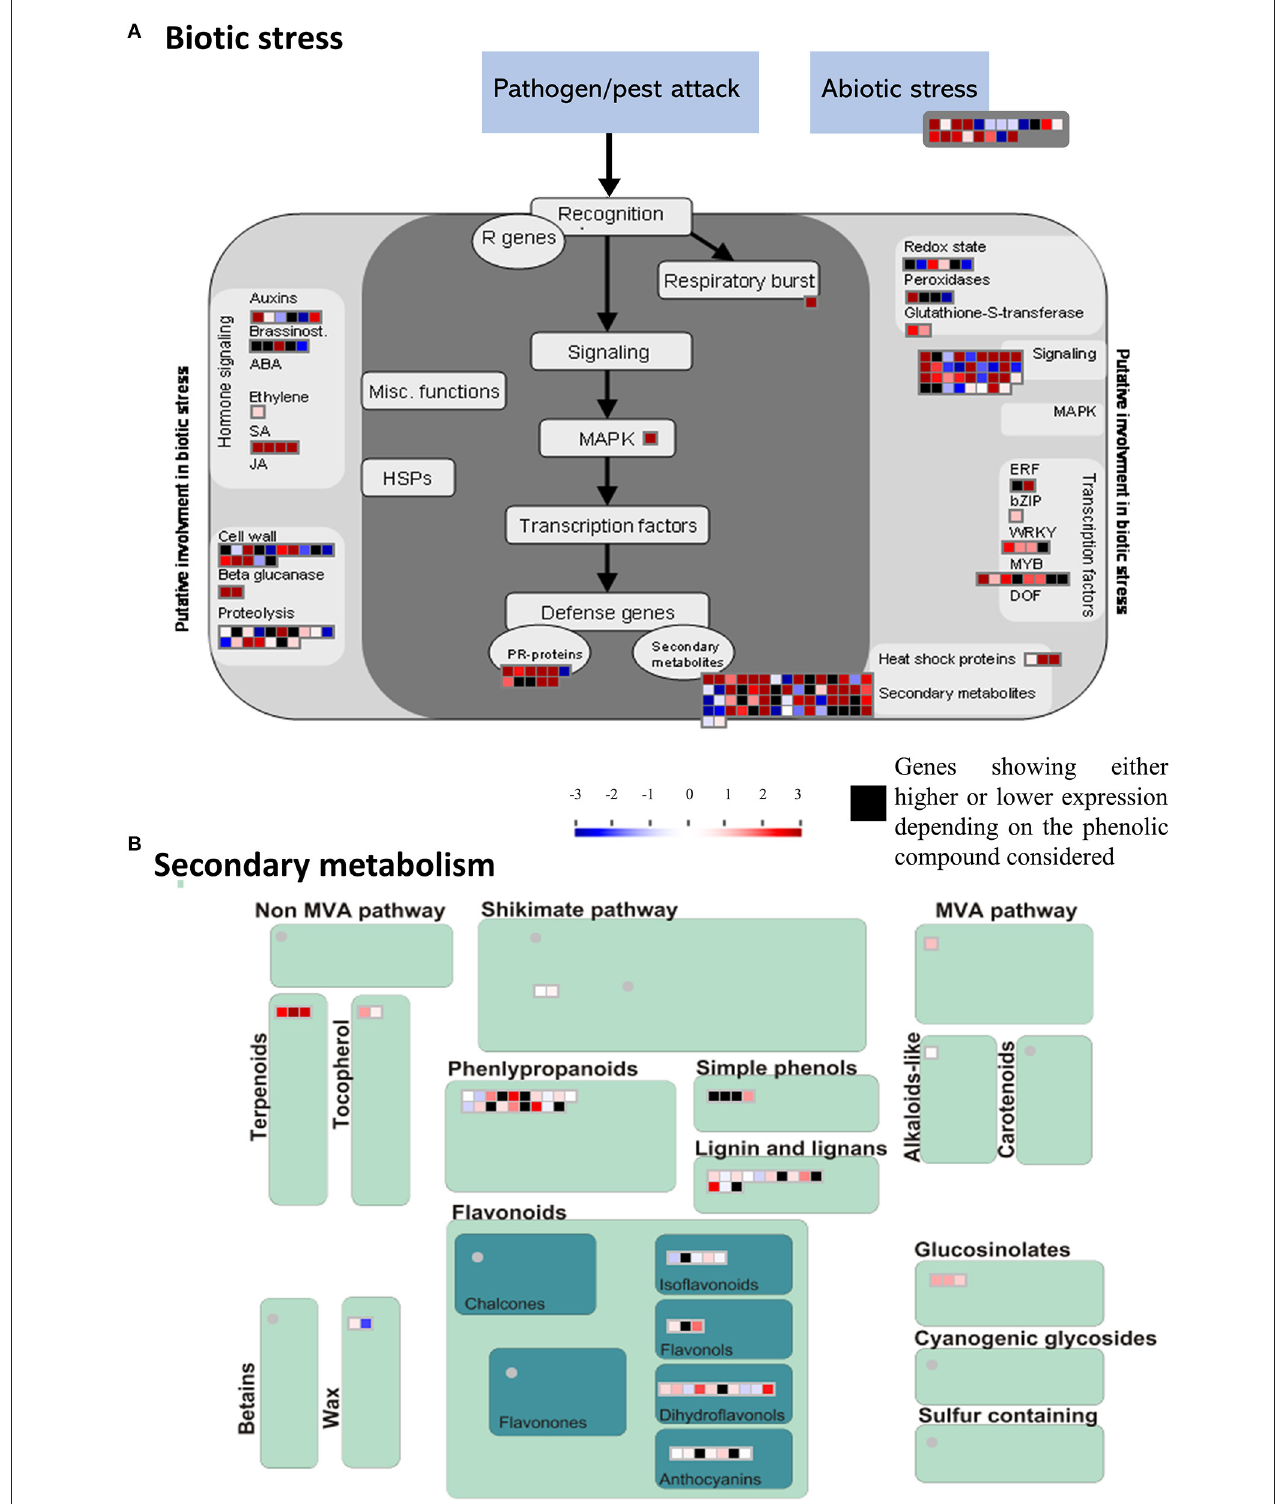
FIGURE 5 | MapMan-based classification of differentially expressed genes (DEGs) involved in stress responses. (A) Expression profiles of DEGs involved in biotic and abiotic stresses. (B) Expression profiles of DEGs involved in secondary metabolism. The scale bar represents positive (red) and negative (blue) regulation of gene expression based on log 2 fc scores. Black squares represent genes that were either high or low expressed depending on the phenolic compound considered.